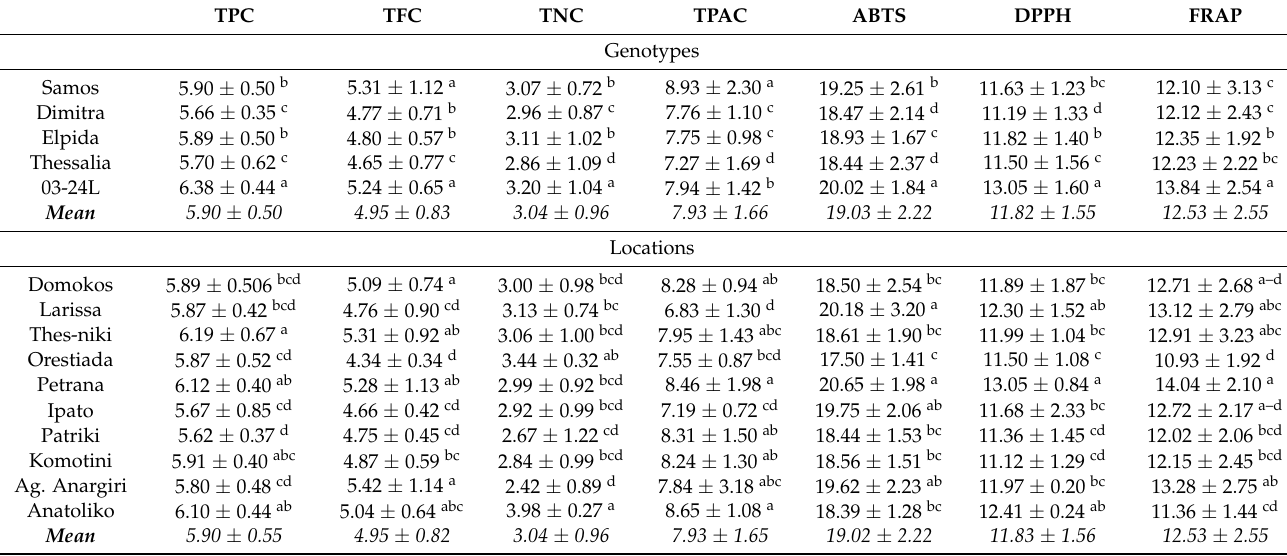
Table 2. Variation in phytochemical components and antioxidant activity of (i) five lentil genotypes averaged across locations and years, (ii) ten locations averaged across genotypes and